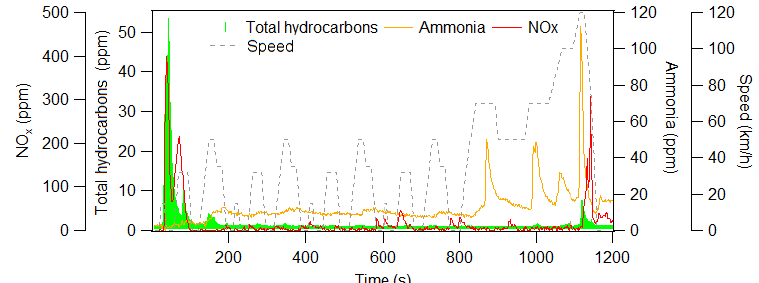
Figure 4. Time series of the exhaust concentrations of total hydrocarbons, ammonia and NO x